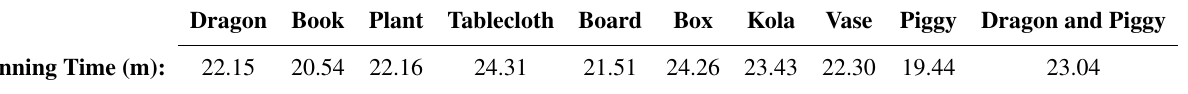
Table 5. Running times for the real-world datasets. The disparity map resolution of all real-world datasets is 1024 × 960 . The corresponding maximum disparity is 107. Dragon Book Plant Tablecloth Board Box Kola Vase Piggy Dragon and Piggy